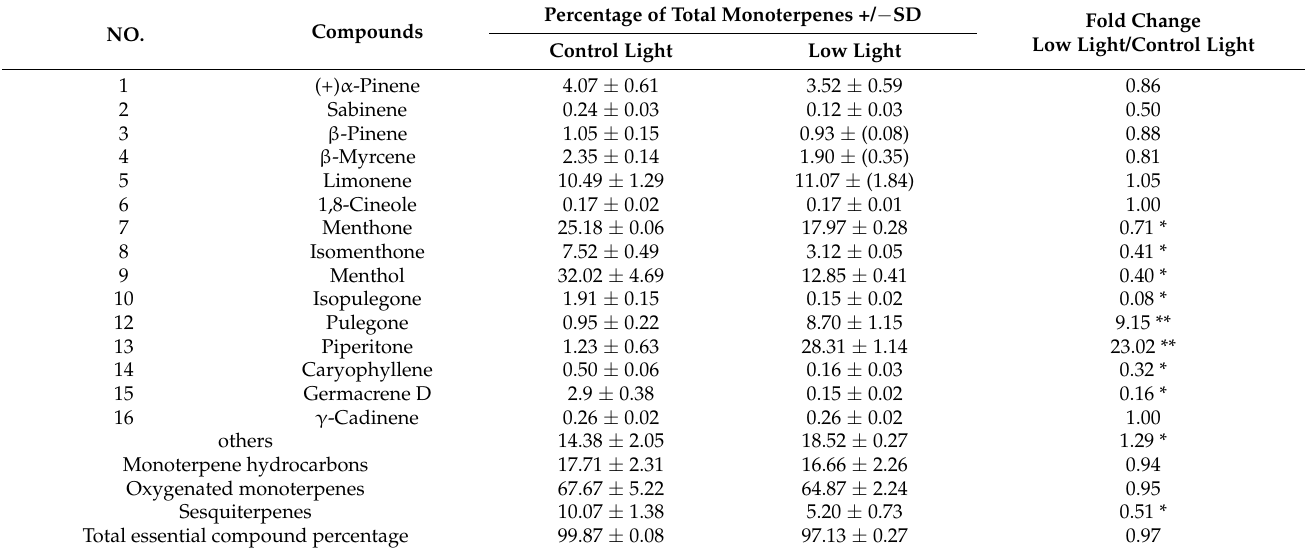
The percentages of total monoterpenes are given as mean values ± SD. The fold change was calculated by dividing the percentages of compounds in darkness-treated leaves by the percentages of compounds in control leaves. The level of significance was obtained